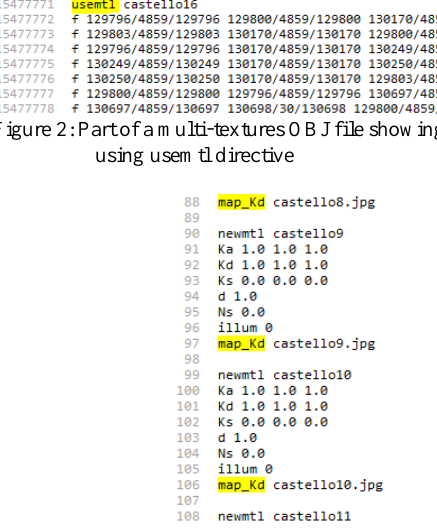
Figure 3: Part of multi-texture mtl file showing mtl section and texture references with map_Kd